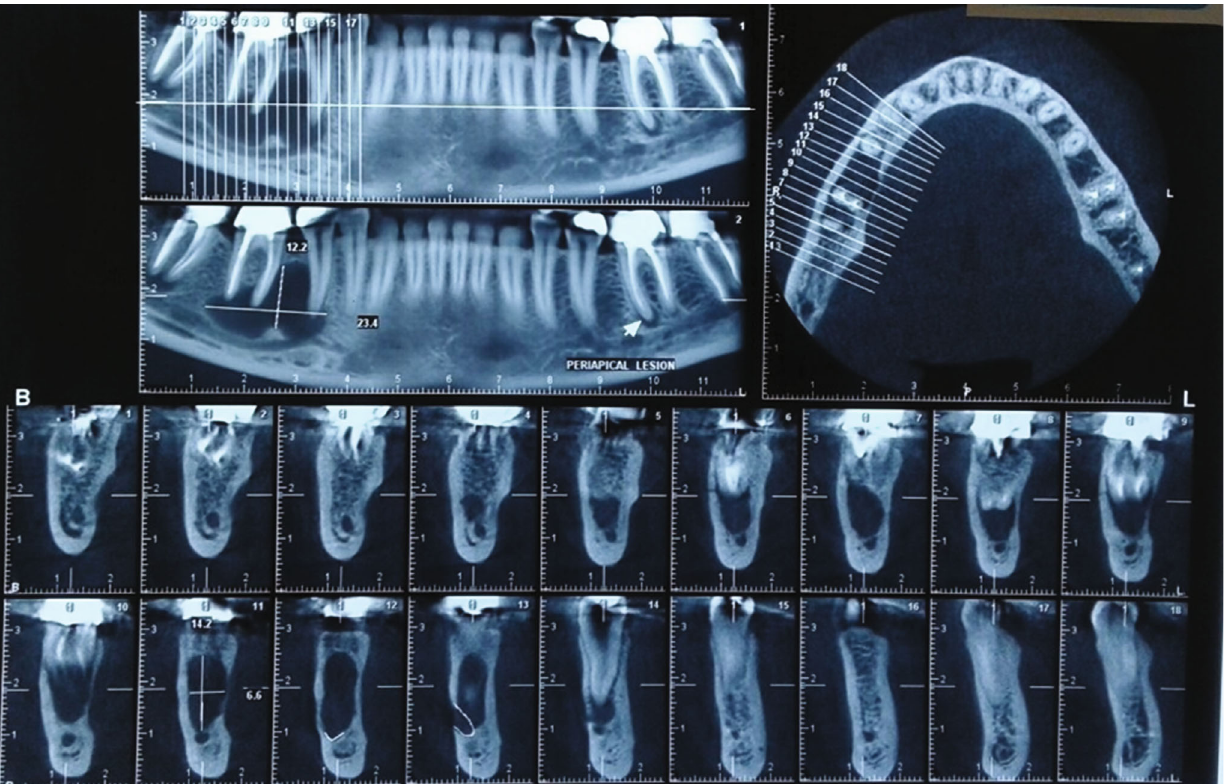
Figure 2: Initial CBCT obtained from the patient further revealing the extents of the